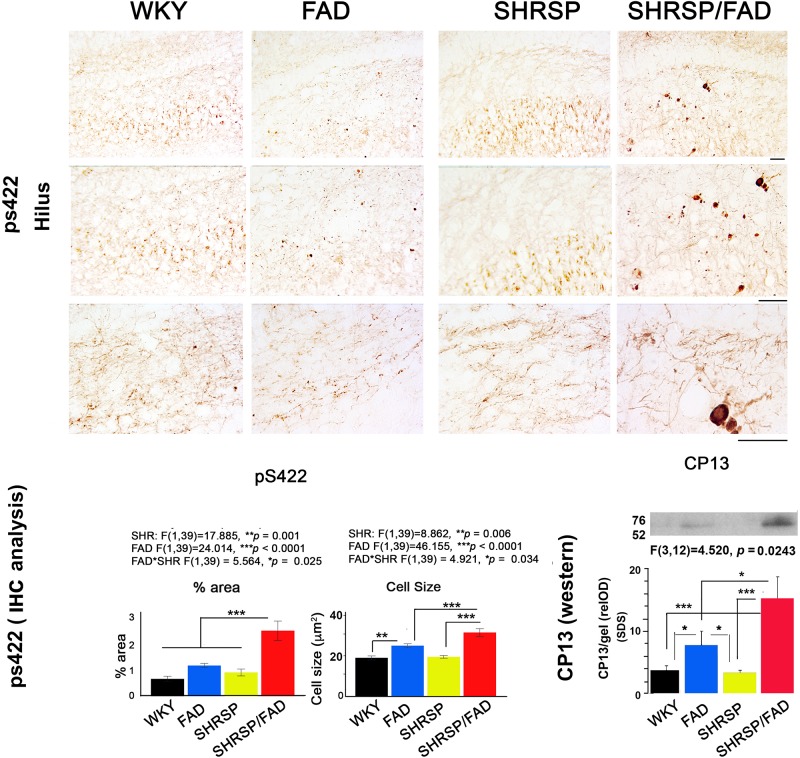
Tau staining and insoluble protein levels are increased in SHRSP/FAD rats. Micrographs depict positive tau pS422 staining in the hilus of the hippocampus of WKY (n = 8), FAD (n = 11), SHRSP (n = 10), and SHRSP/FAD (n = 9) rats. Only SHRSP/FAD rats showed intense staining of neurons labeling globose neurofibrillary tangle-like structures extending tortuous neurites. Two-way ANOVA of percent area and cell size showed significant main effects of SHRSP (p = 0.001, p = 0.006), FAD (p = 0.0001, p = 0.0001) and SHRSP × FAD interactions (p = 0.025, p = 0.034), respectively. Percentage area stained positive for tau pS422 was increased more than two-fold in the SHRSP/FAD rats, compared to WKY, FAD and SHRSP rats (p < 0.0001). Post hoc analysis indicated that cell size was significantly elevated in the hilus of FAD rats, compared to WKY (p < 0.01), while further elevations of tau pS422 cell size were detected in SHRSP/FAD rats, compared to FAD and SHRSP rats (p < 0.001). The lower right panel shows representative lanes from a western blot analysis of CP13, an antibody to the serine 202 phospho-epitope of tau from the insoluble SDS fractions of hippocampal lysates. Two-way ANOVA showed a significant FAD effect and a FAD × SHR interaction. Post hoc analysis showed that there was a non-significant trend for increased CP13 levels in hippocampus from FAD compared to WKY rats (p = 0.08). However, in SHRSP/FAD rats, levels were significantly elevated compared to SHRSP rats (p < 0.001). Furthermore, CP13 levels were significantly elevated in the hippocampus of SHRSP/FAD rats, compared to FAD (p < 0.05). Data represent means ± SEM. ∗p < 0.05, ∗∗p < 0.01, ∗∗∗p < 0.001; two-way ANOVA with LSD Fisher’s post hoc test.